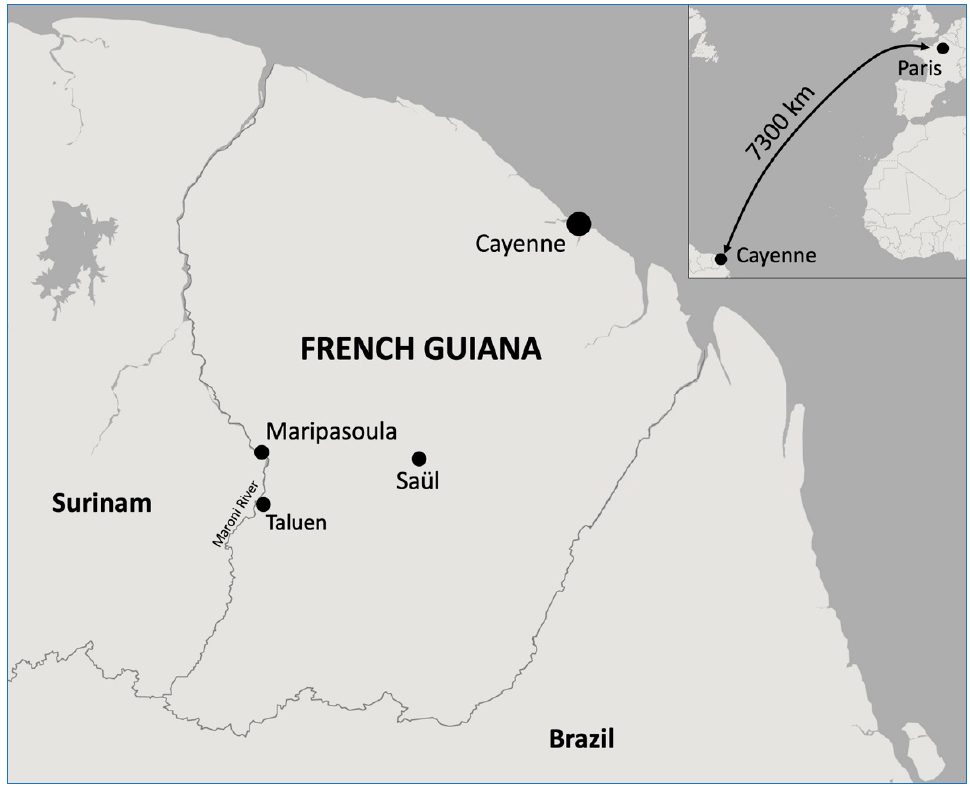
Figure 1. General location of the site under study.